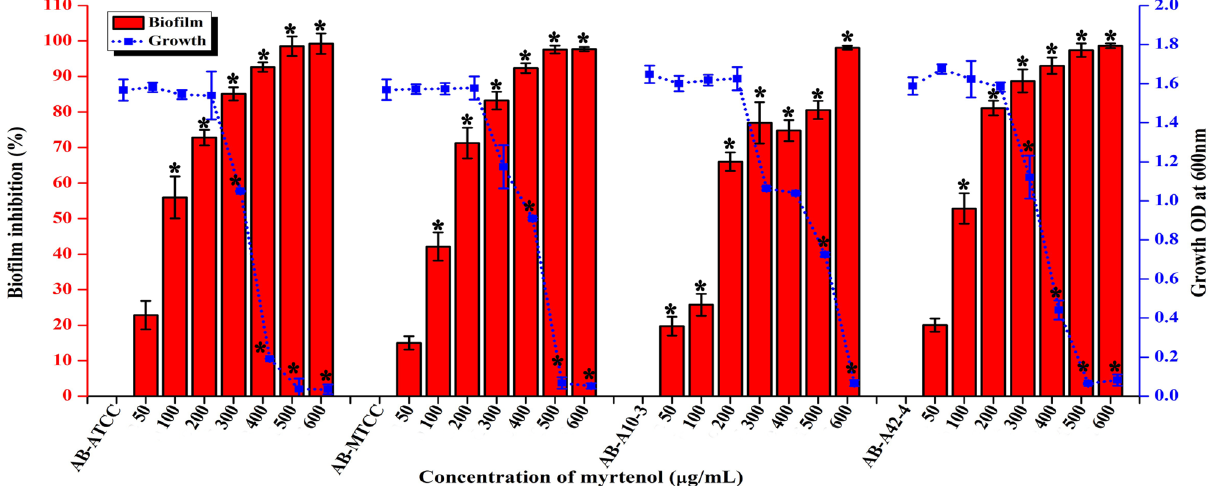
Figure 1. Effect of myrtenol at various concentrations (50–600 μg/mL) on the growth and biofilm formation of AB-ATCC 19606, AB-MTCC 9826, AB-A10-3 and AB-A42-4. Error bars and asterisks indicate the SD and statistical significance ( p < 0.05),